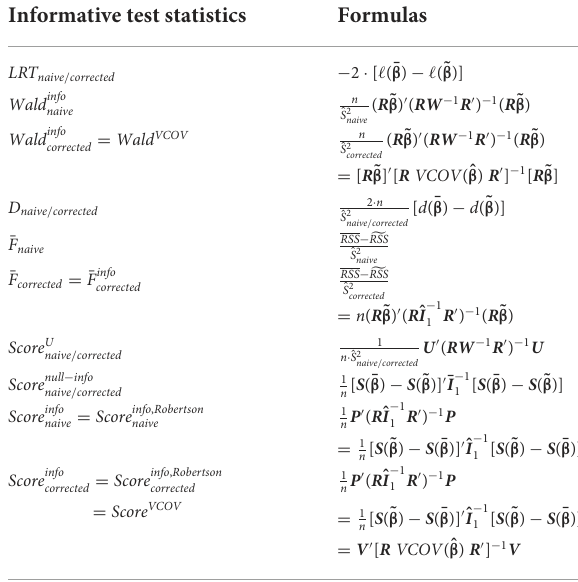
TABLE 2 Overview of all presented informative test statistics. Informative test statistics